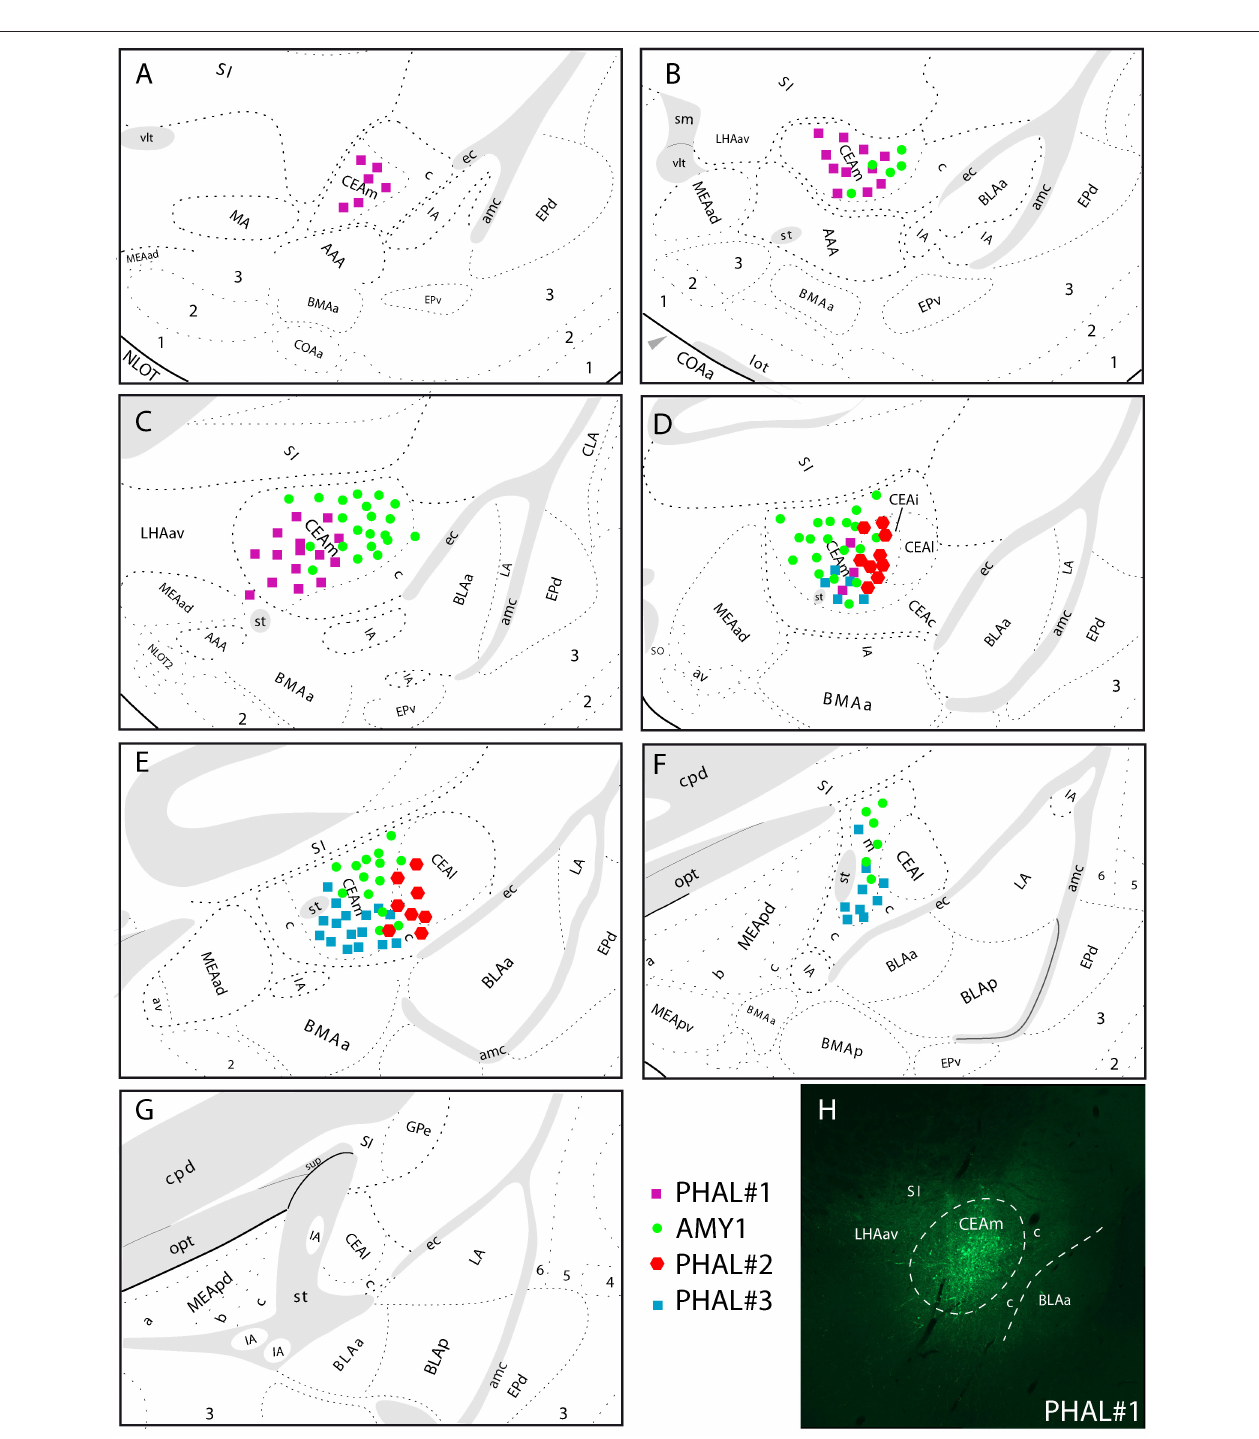
FIGURE 1 | (A–G) Line drawings to illustrate the relative extend of PHAL injection sites in the CEAm and CEAi that contributed to significant innervations of the LHA. PHAL#1 was centered in the rostral CEAm (A–C) . AMY1 mainly extended into central and caudal CEAm (D–F) . PHAL#2 was in the CEAi (D,E) . PHAL#3 is restricted to the caudal CEAm. (H) Photomicrograph to illustrate the PHAL injection site in the experiment PHAL#1.